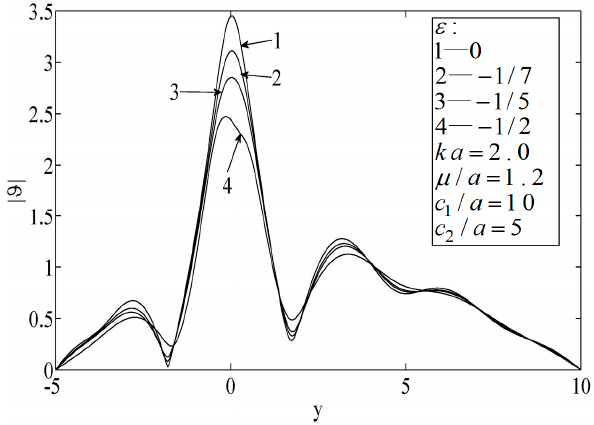
Figure 6. Temperature on the surfaces of the block.